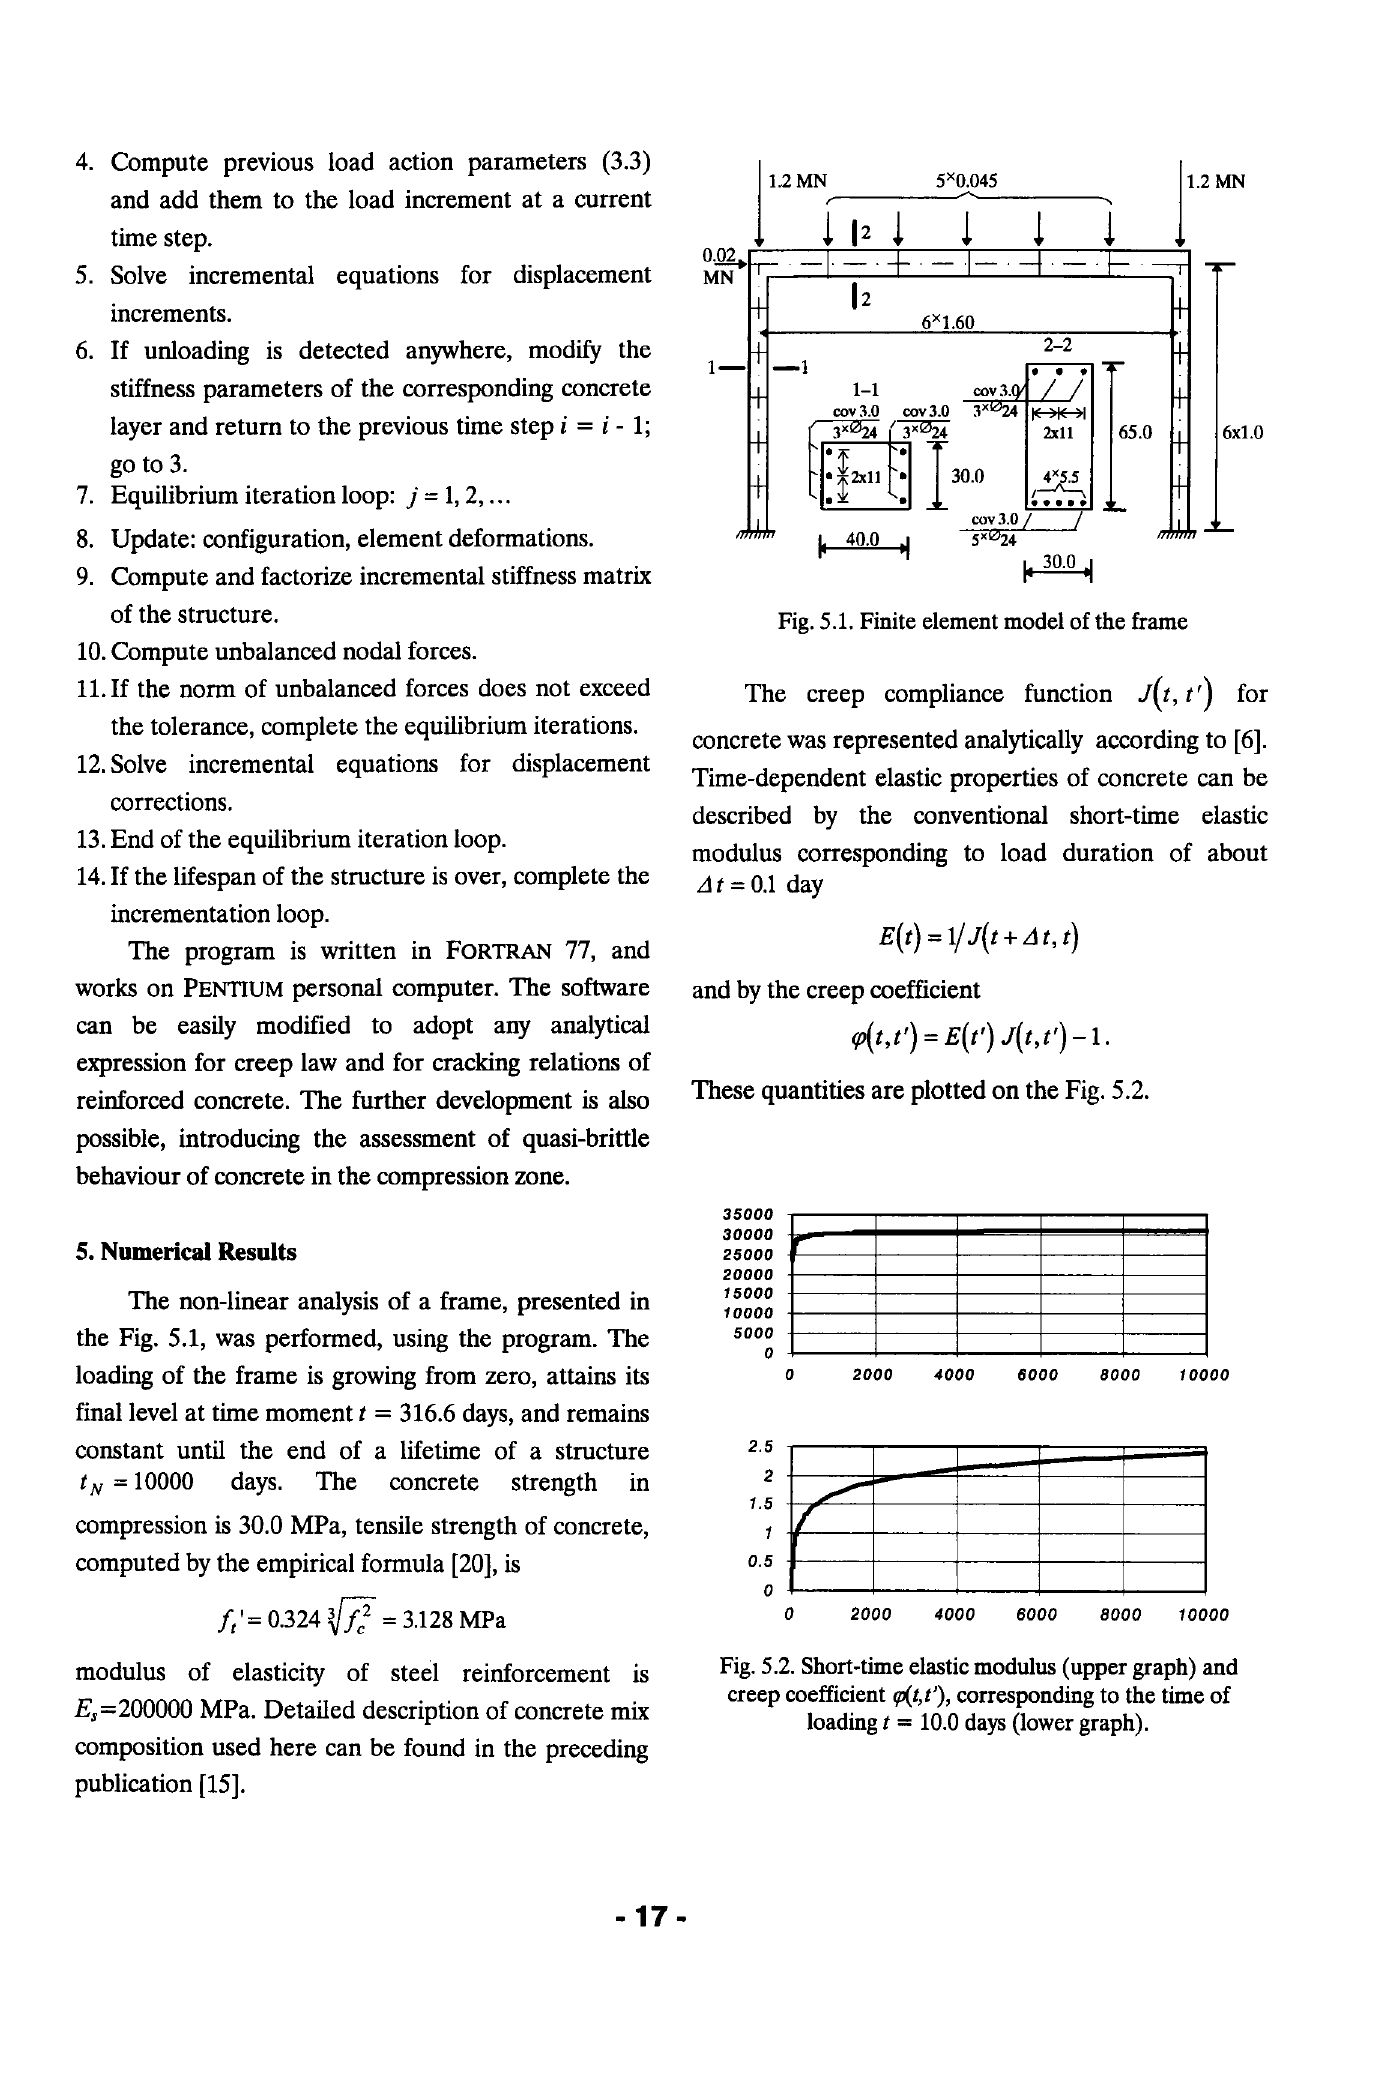
Fig. 5.2. Short-time elastic modulus (upper graph) and creep coefficient qi._t,t'), corresponding to the time of loading t = 10.0 days (lower